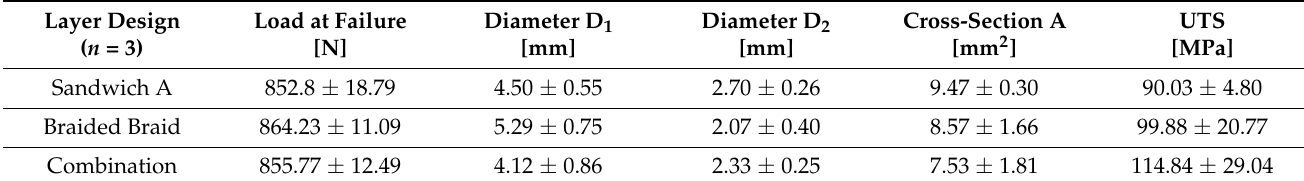
Table 3. Comparison of different layer designs.